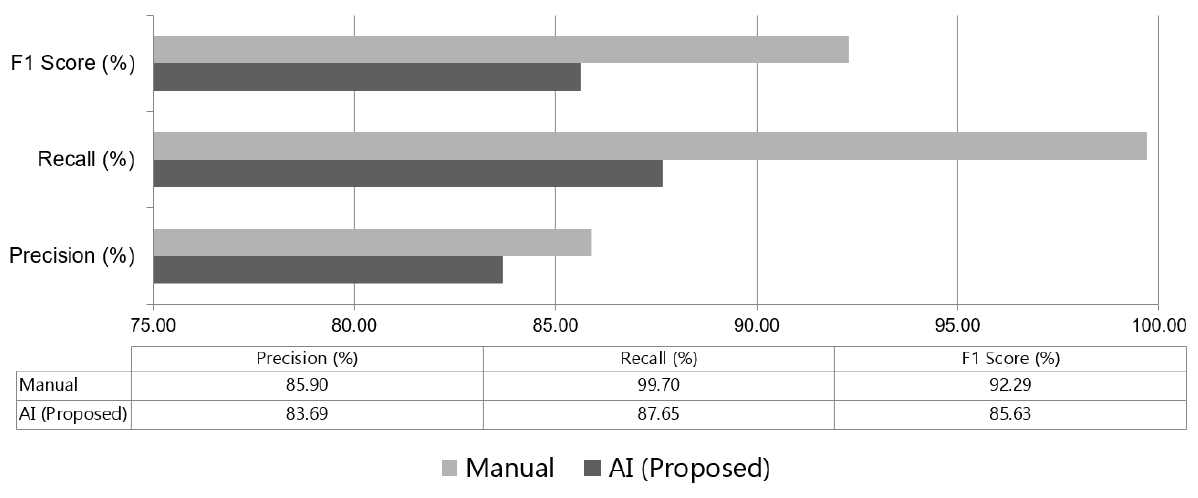
Figure 4. A histogram representation of the classification statistics (precision, recall, and F1 score) for the “Broglie” dataset’s “buildings” class in the 3D space, comparing the proposed method with manual mask